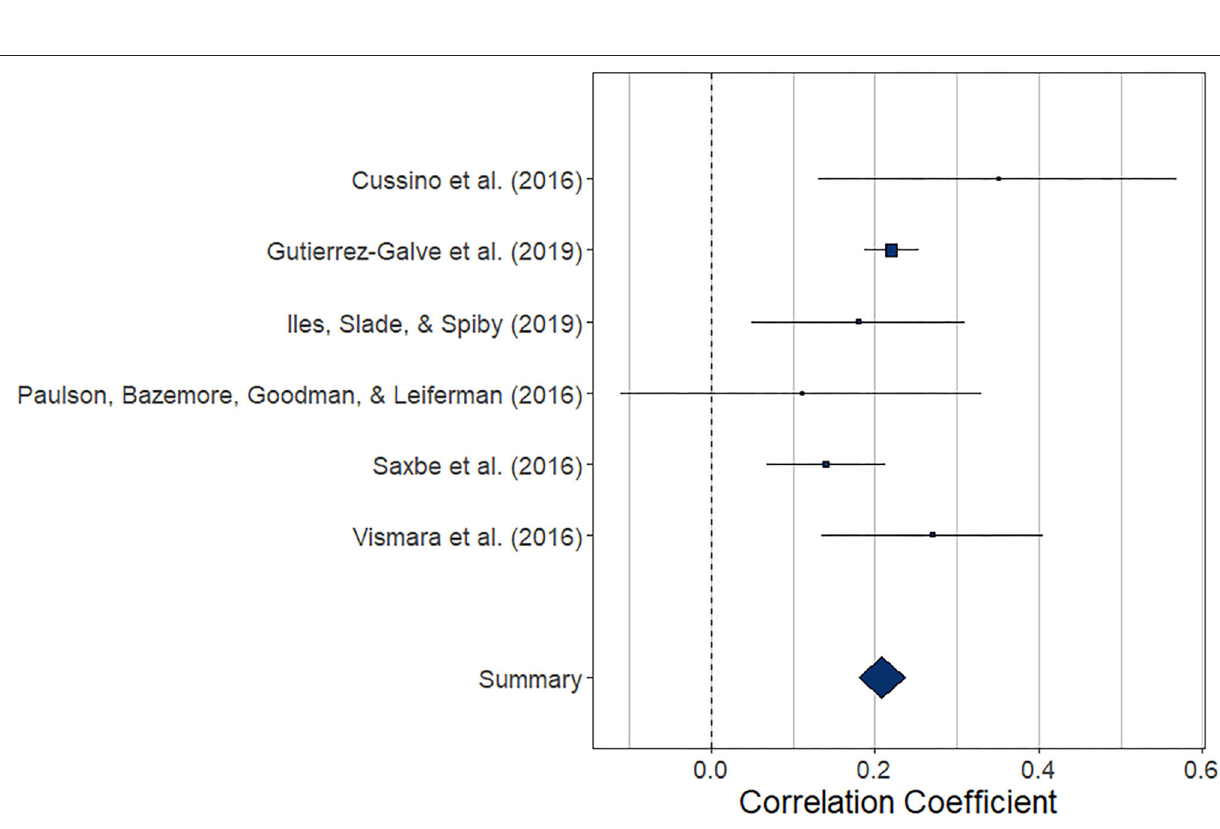
Frontiers in Psychiatry |